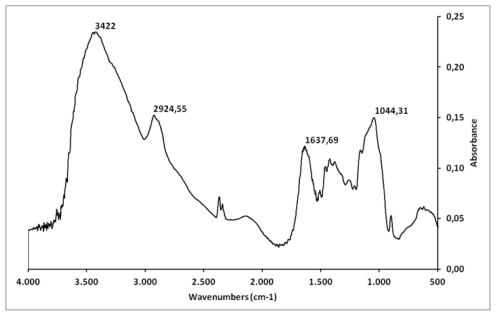
Infrared spectrum of the region between 4000–500 cm−1 of polysaccharides from corn cobs. The peaks highlighted with the numbers above show typical signs of heteroxylan and chemical groups such as glucuronic acid, with a peak of 1637 cm−1.